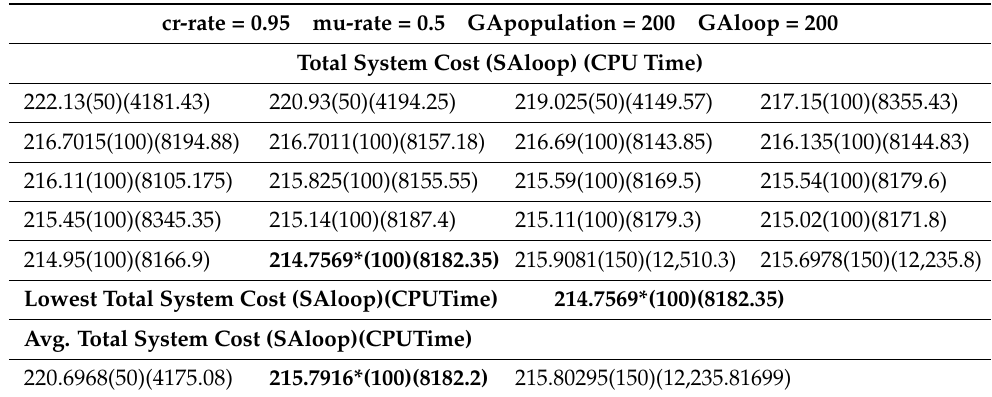
Table 19. The total system costs of 20 simulation runs obtained by SA–MGA for the parallel-series